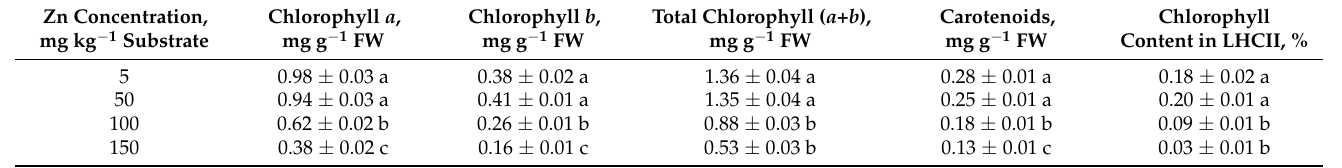
Table 3. Effect of Zn excess on photosynthetic pigment content in S. alba seedlings.